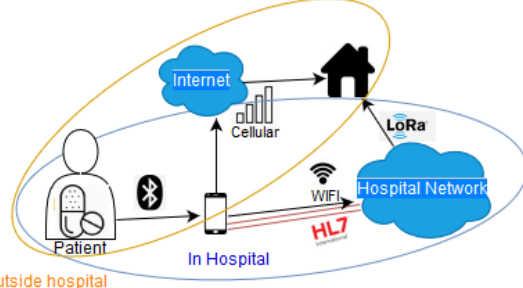
Figure 3. Operation of an ingestible smart